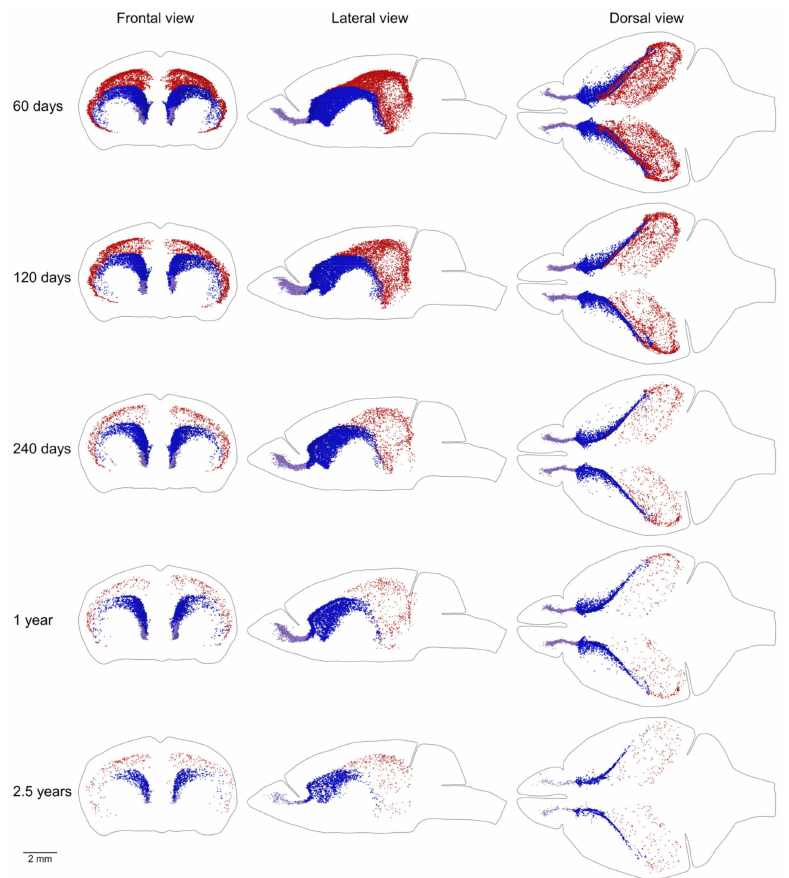
Figure 8. Distribution of proliferating cells in the caudate migratory stream (CMS), midlayer, and rostral migratory stream (RMS). Each EdU-labeled nucleus located in the CMS is shown as a blue dot, in the midlayer as a red dot, and in the RMS as a lilac dot. The scale is shown at the bottom. The brain shape is outlined with a black line. Frontal, lateral, and dorsal views of the brain are shown. Mouse age is shown on the